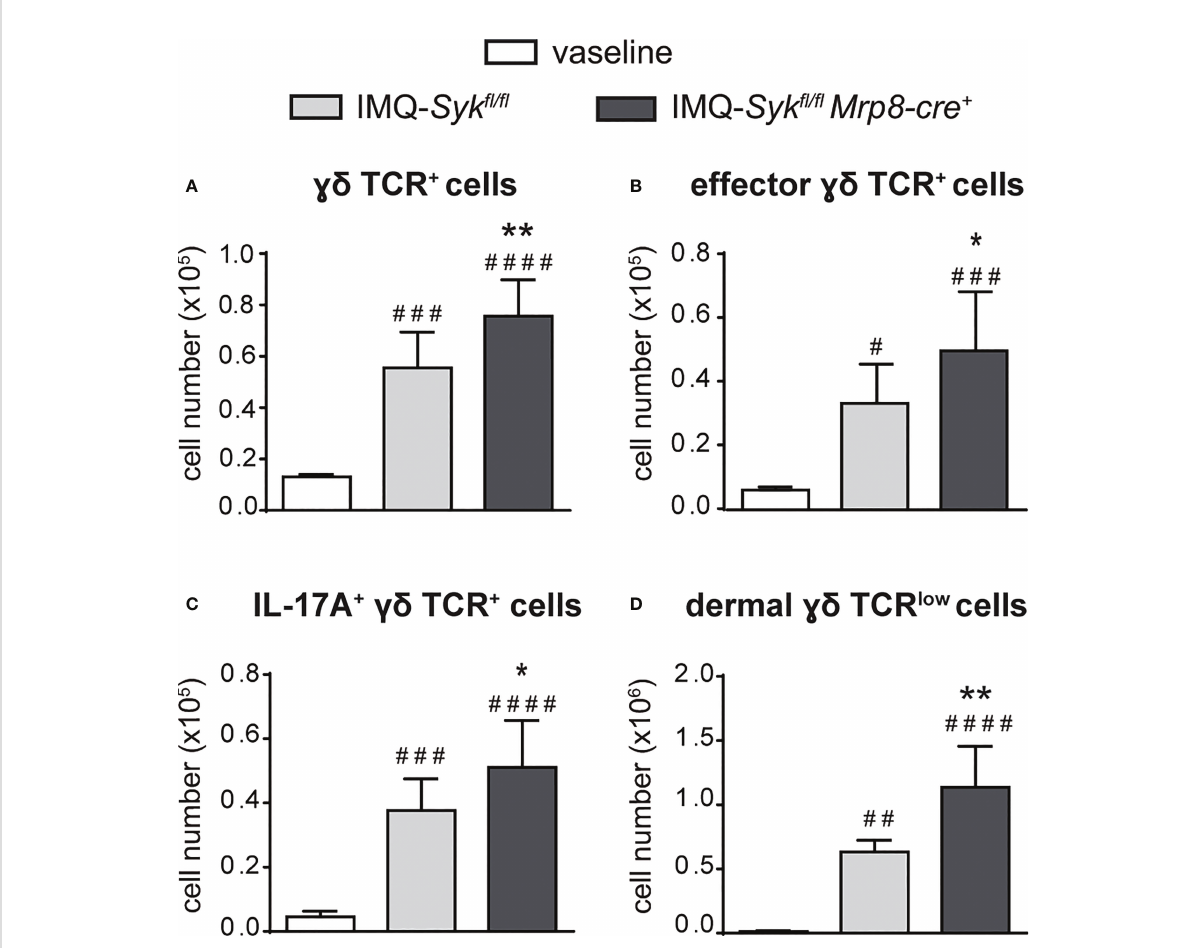
FIGURE 9 In fi ltration of neutrophils and gd T cells in the draining lymph nodes and skin of IMQ-treated Syk fl / fl and Syk fl / fl Mrp8-cre + mice. The dorsal skin of control Syk fl / fl and Syk fl / fl Mrp8-cre + mice was topically treated with IMQ-containing cream (Aldara ® ) or vaseline for 6 consecutive days. Draining lymph nodes (A-C) or the total skin (2x2 cm) (D) were collected and analyzed by fl ow cytometry. Panels report: the number of total ( A ), effector (CD44 high CD62L low ) (B) and IL-17A-producing (C) lymph node gd TCR + cells; the number of skin dermal gd TCR low T cells ( D ). Data are pooled from 2 separate experiments and are expressed as means ± SD (n = 11 mice). Statistical differences of IMQ-treated Syk fl / fl or Syk fl / fl Mrp8-cre + vs . vaseline-treated mice (#) and IMQ-treated Syk fl / fl vs . IMQ-treated Syk fl / fl Mrp8-cre + mice (*) are reported. * P ≤ 0.05; ** P ≤ 0.01; # P ≤ 0.05; ## P ≤ 0.01; ### P ≤ 0.001; #### P ≤ 0.0001 by 1-way ANOVA with Bonferroni ’ s